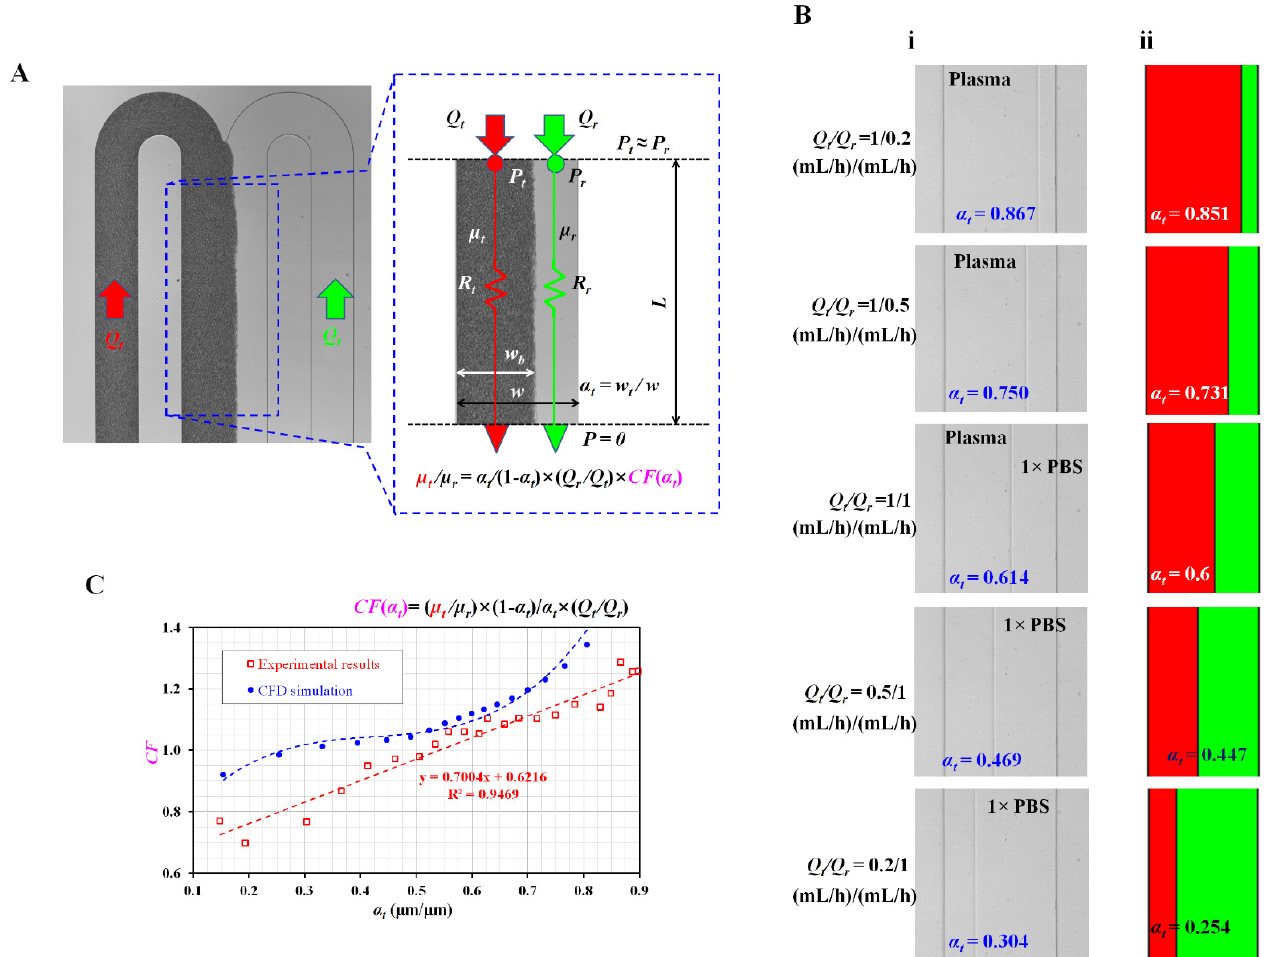
Figure 2. Derivation of blood viscosity formula in terms of fluidic circuit elements. ( A ) Mathematical representation of co-flowing channel. ( B ) Quantitative comparison between the experimental and numerical simulation results. (i) Experimental results showing variations of interface with respect to flow-rate ratio ( Q t / Q r ) ( Q t / Q r = 1/0.2, 1/0.5, 1/1, 0.5/1, and 0.2/1). (ii) Numerical simulation results showing variations of interface with respect to Q t / Q r . ( C ) Variations of CF obtained by experimental and numerical simulation results with respect to the interface. Based on linear regression analysis of the experimental results, the CF was best fitted as CF = 0.7004 α t + 0.6216 (R 2 = 0.9469).